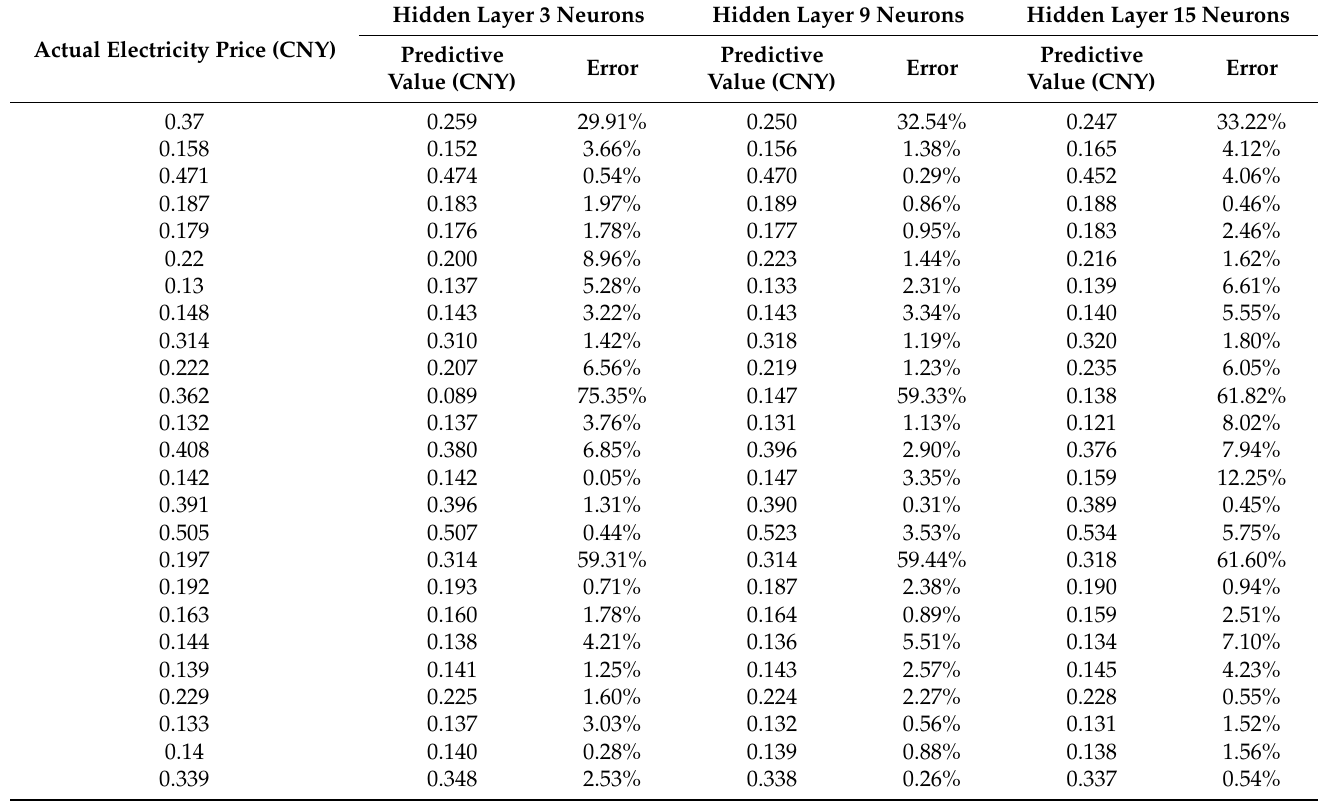
Table 5. Predictive value and error using